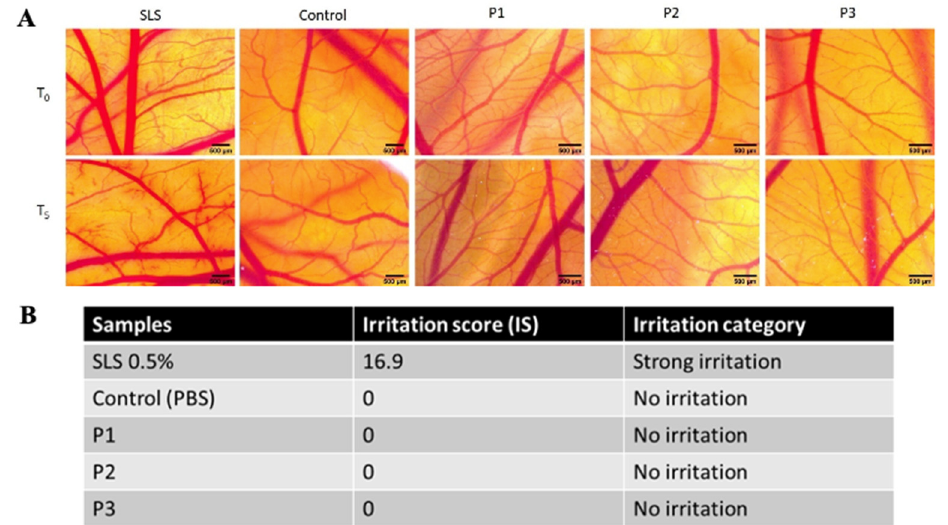
Figure 6. Irritation evaluation using the hen’s egg test-chorioallantoic membrane (HET-CAM) assay. ( A ) Stereomicroscopic images of the CAM vasculature before treatment (T0) and 5 min after treatment with extraction medium of test orthodontic implants P1, P2, and P3, next to sodium lauryl sulfate (SLS) 0.5% (positive control) and phosphate buffered saline (PBS) (negative control); scale bars 500 µm. ( B ) Irritation scores of the test orthodontic implants P1, P2, and P3. The experiment was performed in triplicate.